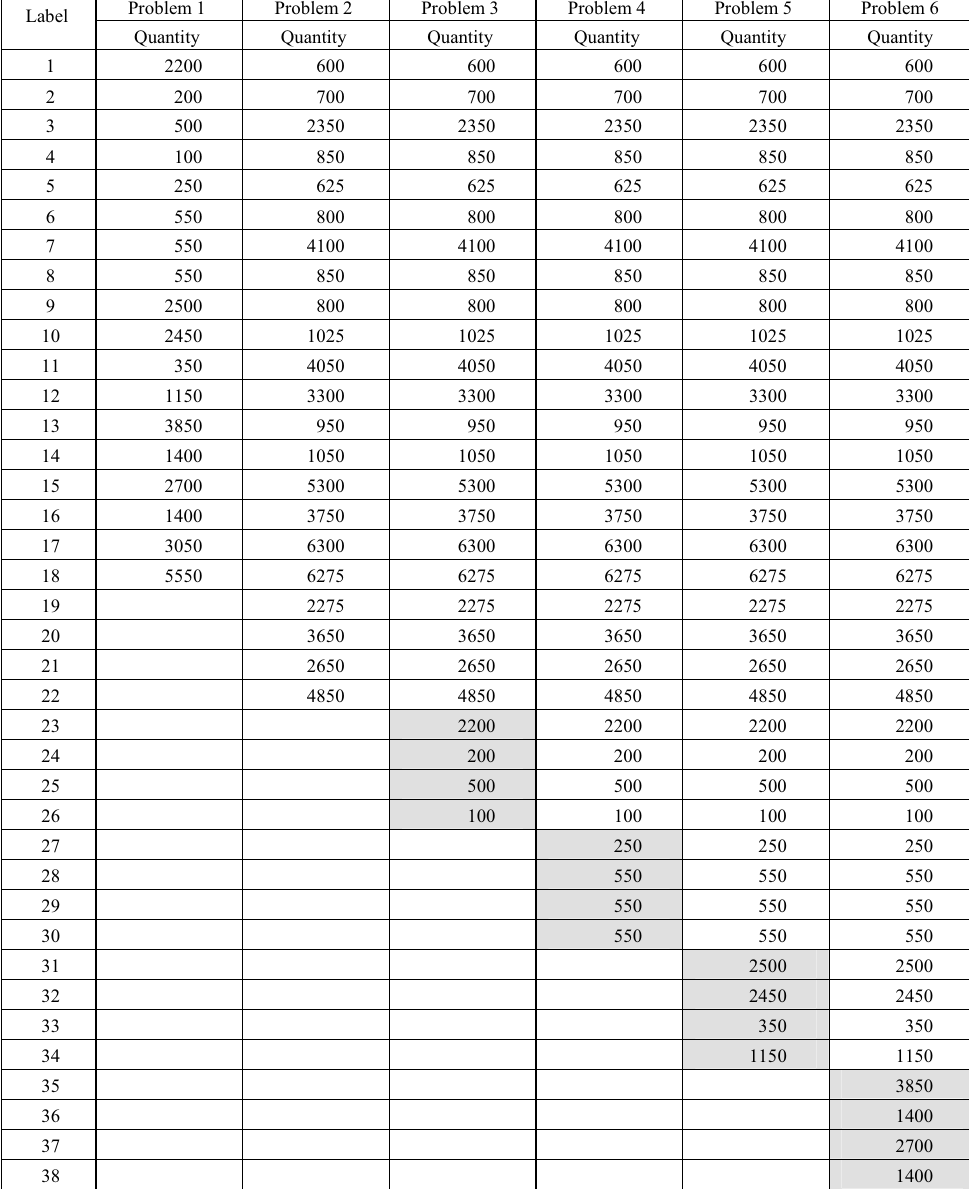
Table 1. The data of six main test problems for